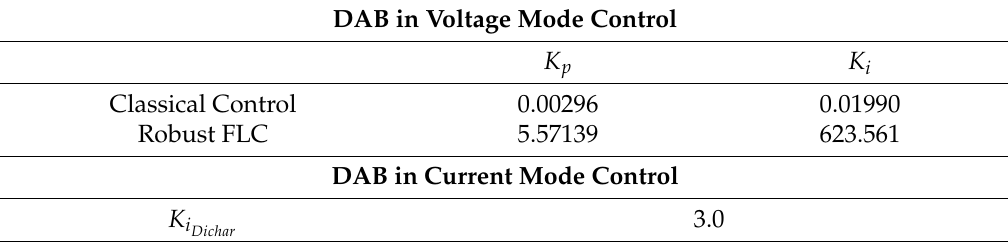
Table 3. Designed controllers for DAB